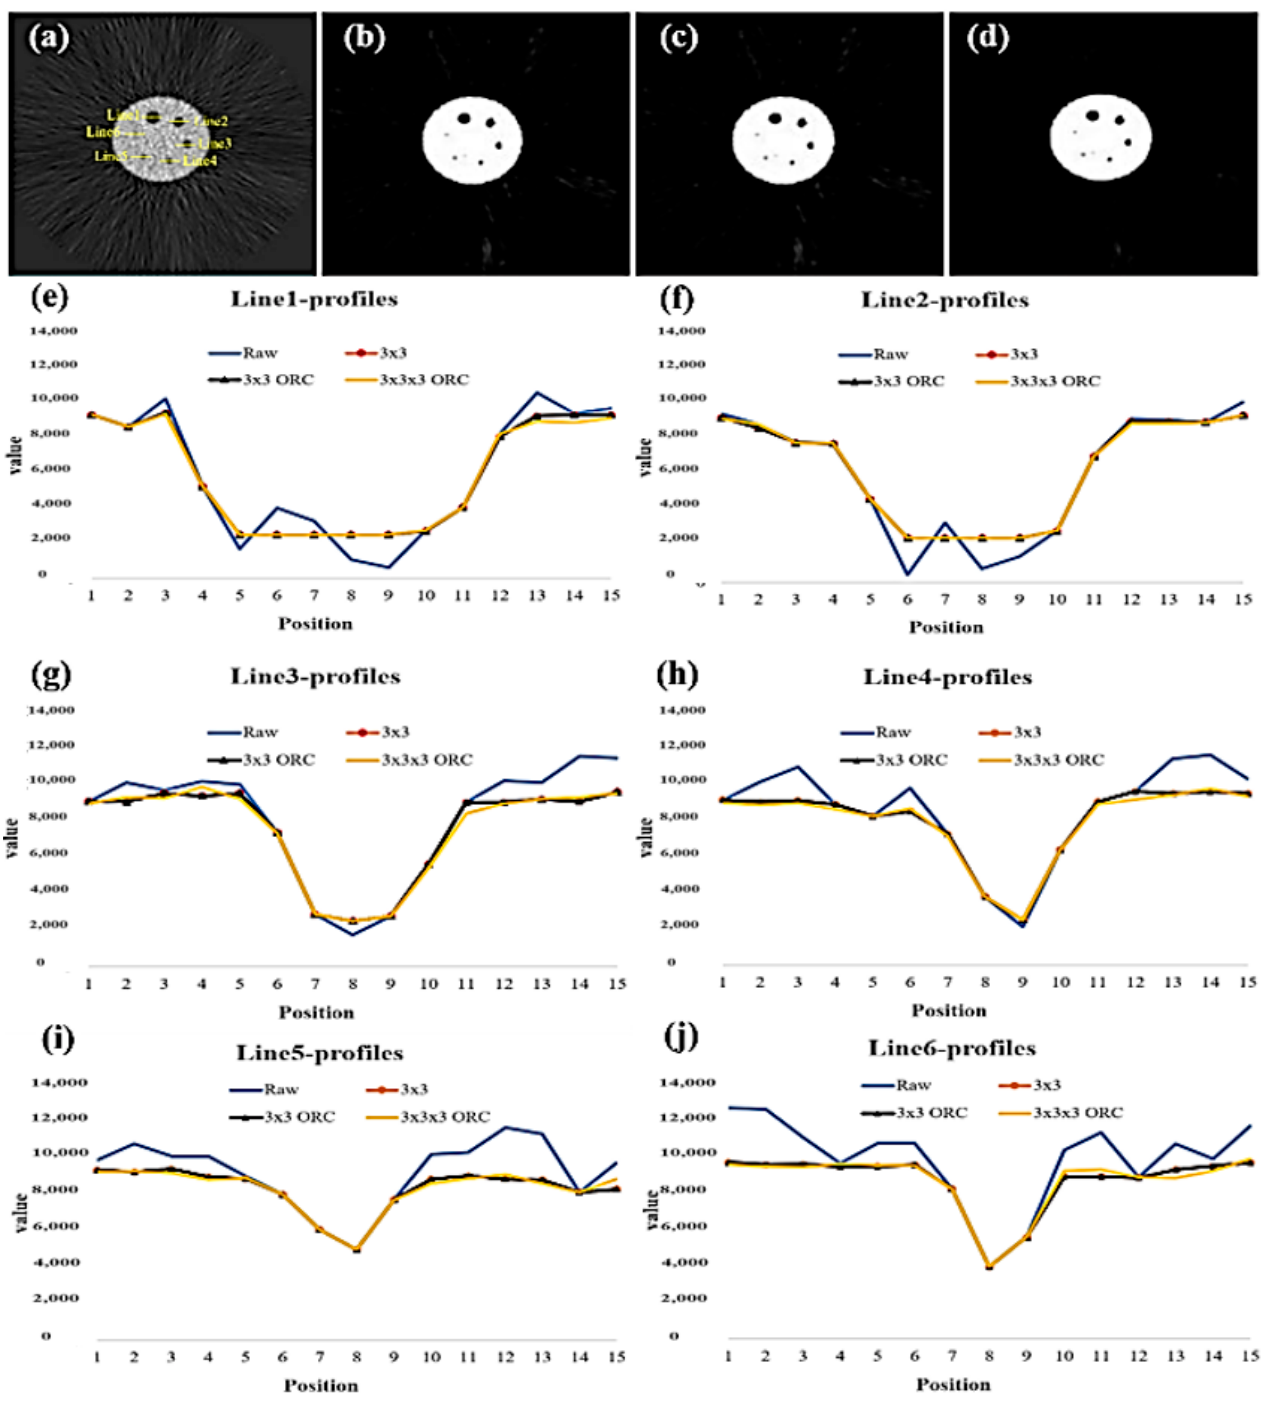
Figure 7. Total aperture of line-profiles in the FBP image of Deluxe Jaszczak phantom is shown ( a ), and FWHM were computed individually. A post-processing image by a 2D 3 × 3 MSO ( b ) and a 2D MSO with ORC ( c ). A post-processing image by a 3D 3 × 3 × 3 MSO with ORC ( d ). All aperture of line-profiles with/without MSO are shown ( e – j ).